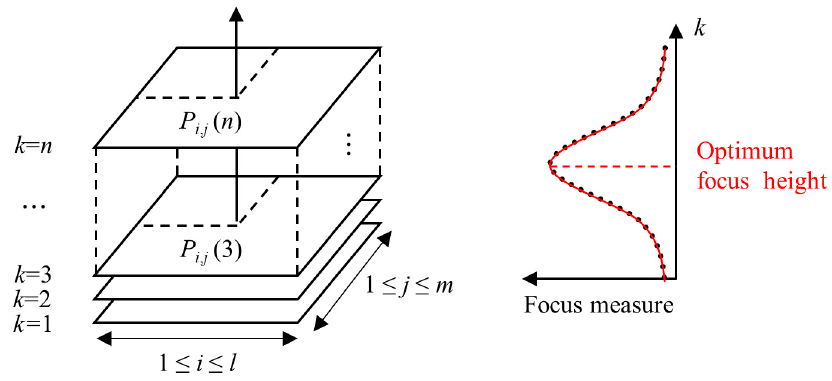
Figure 1. Principle of shape from focus.